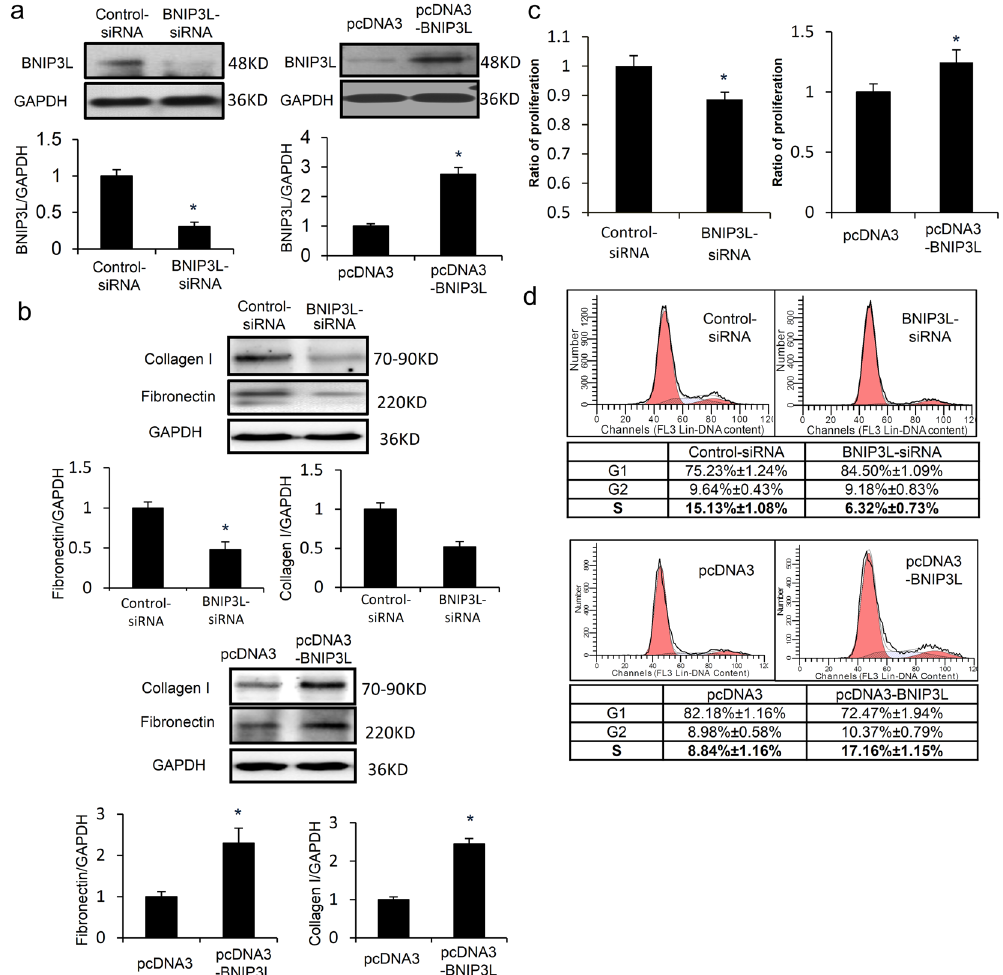
Figure 4. The roles of BNIP3L in CFs. Neonatal rat CFs were transfected with the BNIP3L and BNIP3L-siRNA adenoviruses. ( a ) Western blot analysis showing the effects of the adenoviruses on BNIP3L expression. ( b ) Western blot analysis showing the effects of BNIP3L on fibronectin and collagen I expression. ( c ) Proliferation was measured using the MTT assay. ( d ) Cell cycle stage was determined by FACS, and the data were analyzed using the ModFit program. Each experiment repeated three times. Data shown are mean ± SD, * P < 0.05 vs.